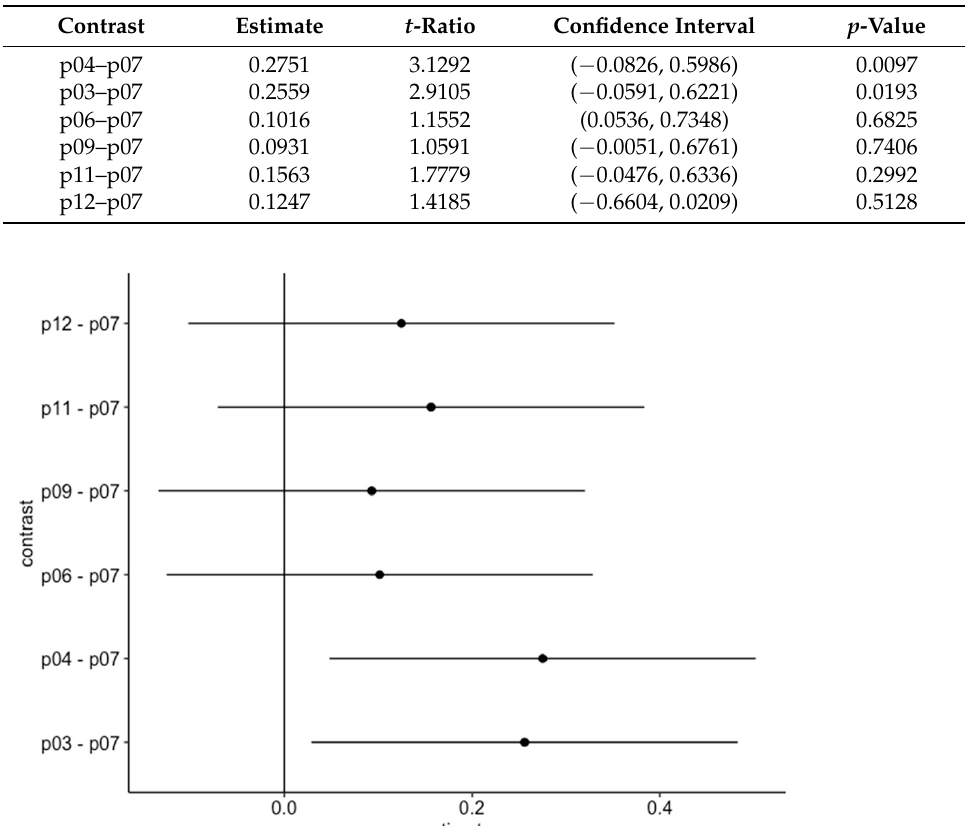
Figure 13. Fisher ANOVA on energy at different plots. Table 4. Pairwise comparison test (with Dunnett’s method adjustment) on energy from different plots (SE = 0.08792941; df = 59465).